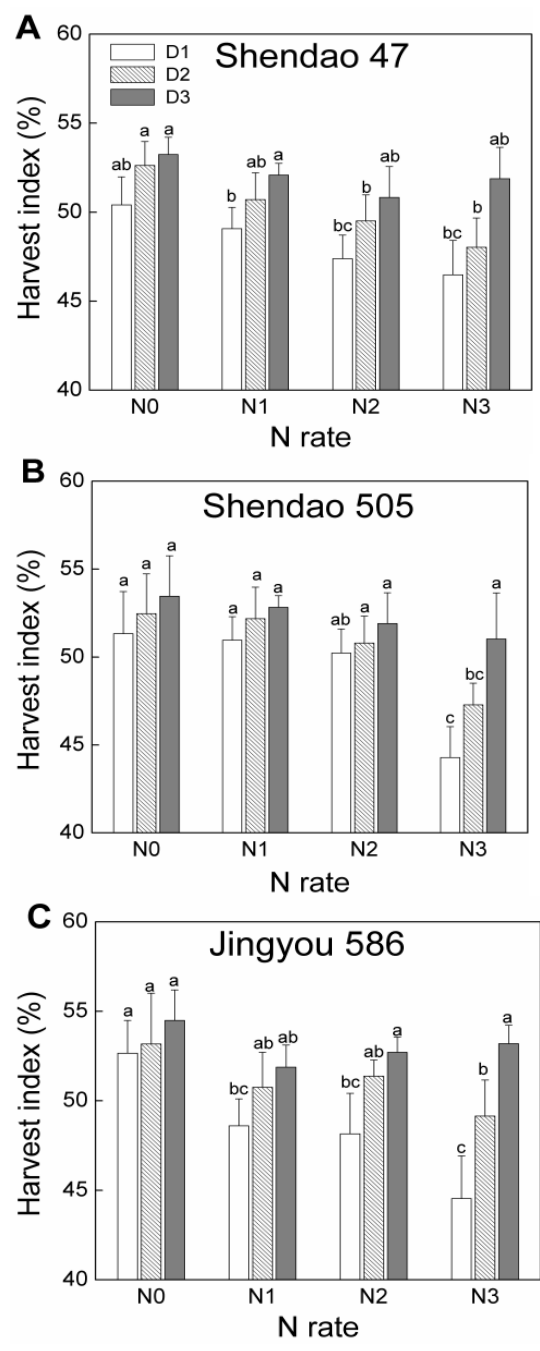
Figure 2. Mean harvest index of Shendao 47 ( A ), Shendao 505 ( B ), and Jingyou 586 ( C ), averaged across N treatments, locations, and years. Error bars represent + S.E. of the mean. The S.E. was calculated across two sites and two years. Different letters indicate significant differences at p < 0.05.